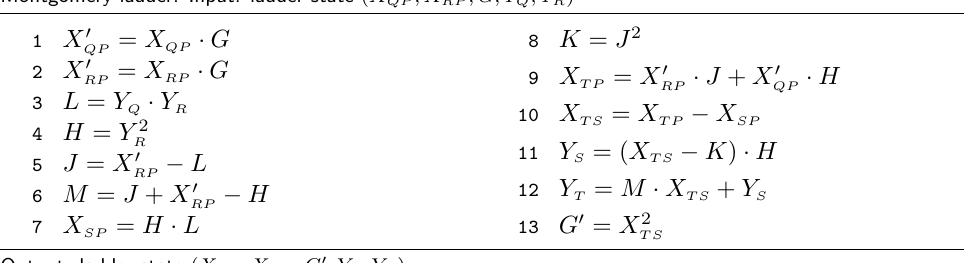
, X , M, Y ) Montgomery ladder. QP RP P